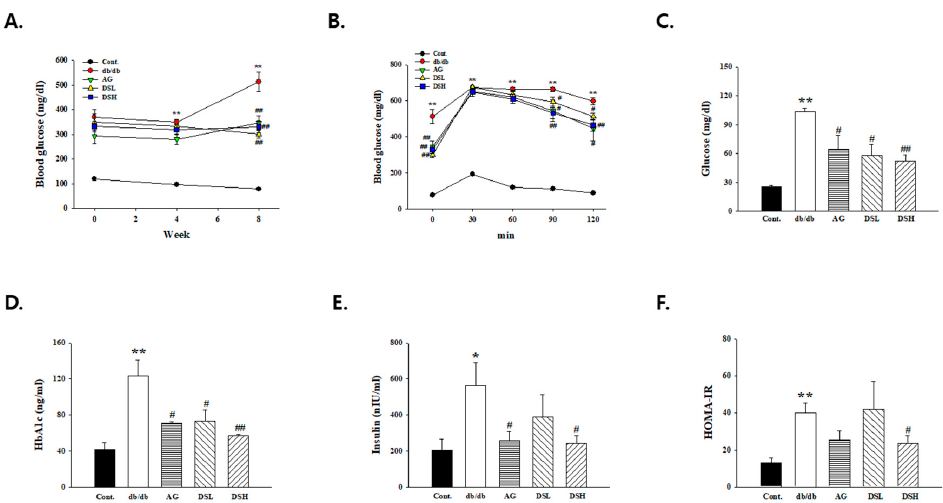
Figure 4. Effect of DS-EA on blood glucose ( A ), oral glucose tolerance test ( B ), glucose ( C ), HbA1c ( D ), insulin ( E ), and HOMA-IR ( F ). Values are expressed as mean ± S.E. ( n = 5). * p < 0.05, ** p < 0.01 vs. Cont.; # p < 0.05, ## p < 0.01 vs. negative Cont.; Cont.: db/m mice group; db/db: db/db mice group (negative Cont.); AG: db/db mice treated with aminoguanidine group; DSL: db/db mice treated with low-dose DS-EA group; DSH: db/db mice treated with high-dose DS-EA